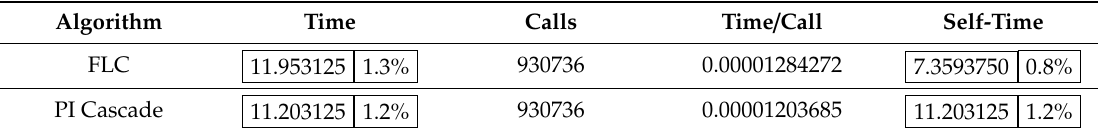
Table 7. Comparison by summary of the